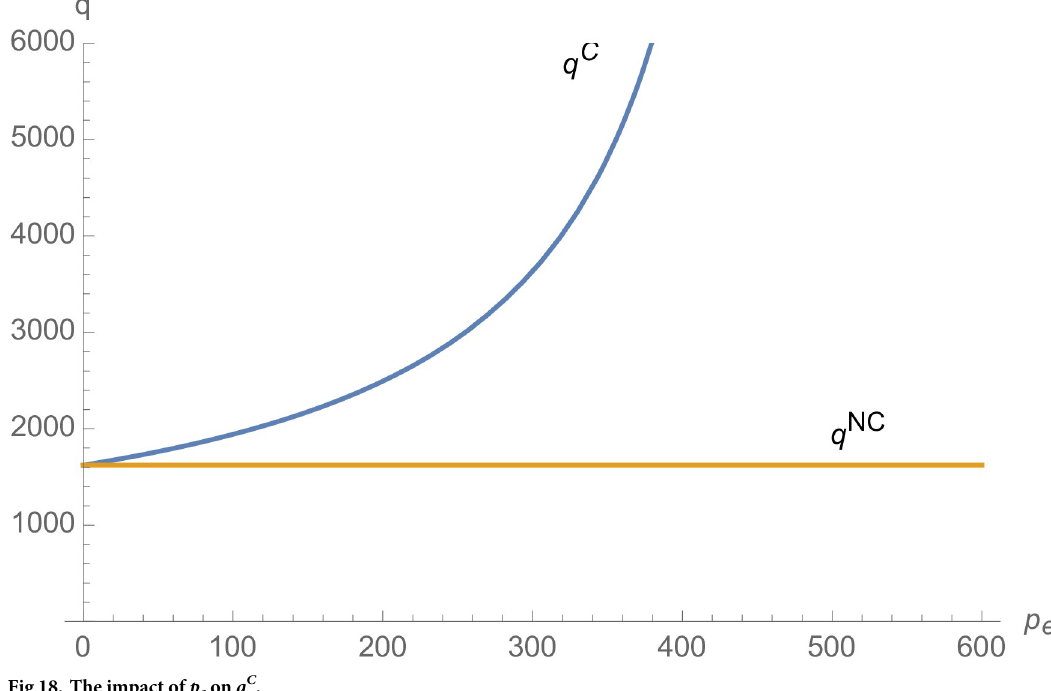
Fig 18. The impact of p